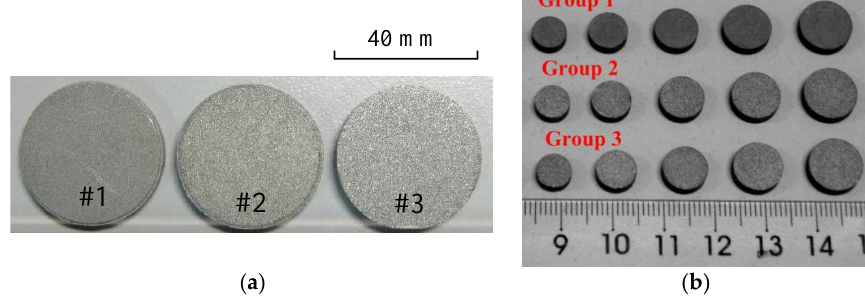
Figure 2. Photographs of the porous medium: ( a ) Original porous media; ( b ) test porous media.